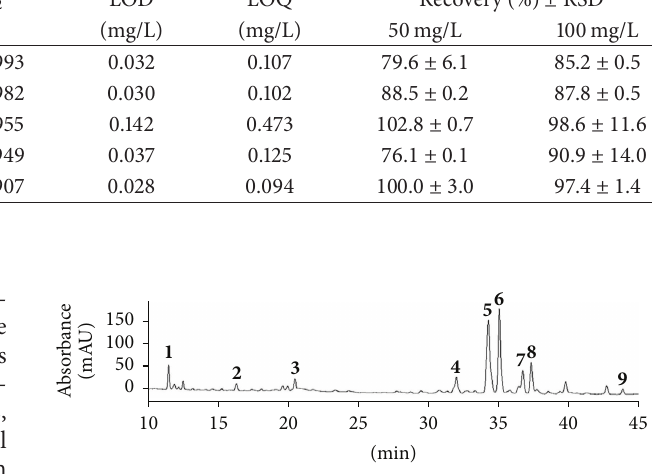
Figure 1: Chromatograms of the Euphorbia supina polyphenol mixtureobtainedusinghigh-performanceliquidchromatography: 1 , gallic acid; 2 , protocatechuic acid; 3 , nodakenin; 4 , quercetin 3- O - hexoside; 5 , quercetin 3- O -pentoside; 6 , kaempferol 3- O -hexoside; 7 , kaempferol 3- O -pentoside; 8 , quercetin; 9 , kaempferol. Detection wavelength: 254 nm.